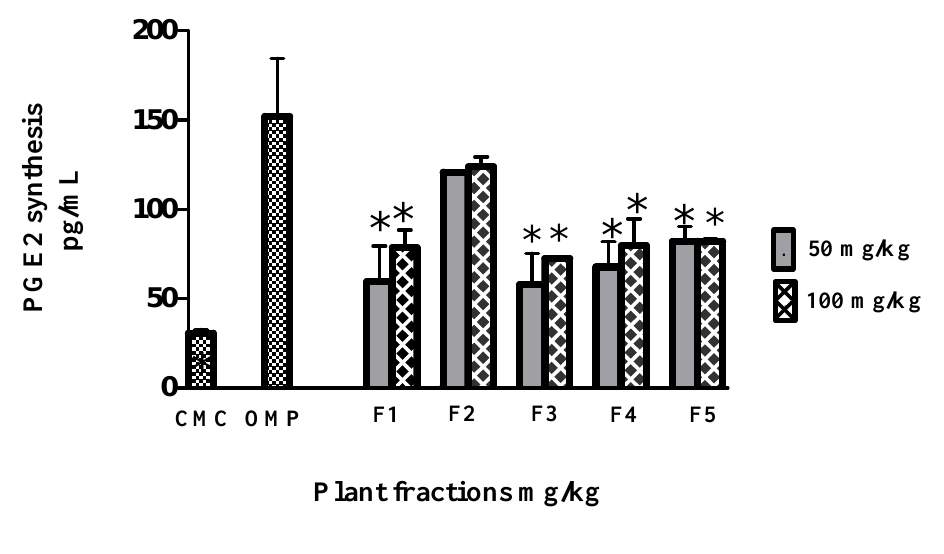
Figure 5. Effect of the fractions obtained from Polygonum minus on the PGE2 synthesis level in gastric tissue. Data are expressed as mean ± SEM ( n = 6) * significantly different in comparison to omeprazole, p < 0.05 using one-way